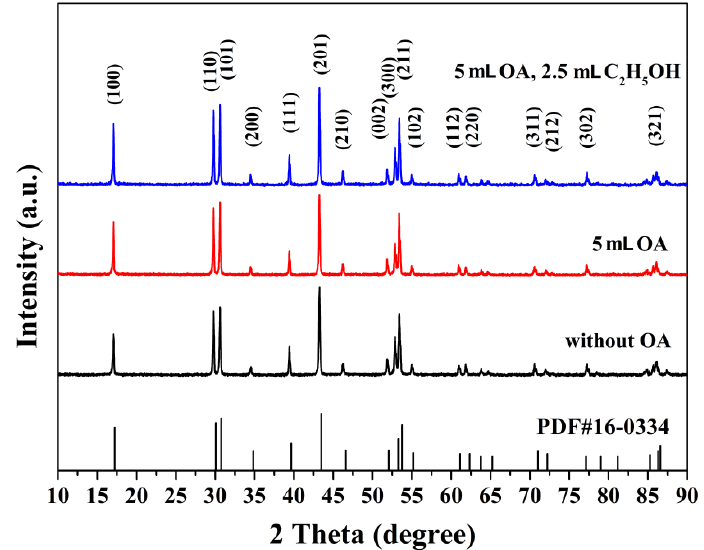
Figure 2. XRD patterns of β -NaYF 4 :Eu 3+ , prepared without oleic acid (OA), with 5 mL OA, and with 5 + 2.5 mL C mL OA + 2.5 mL C 2 H 5 OH. 5 mL OA 2 H 5